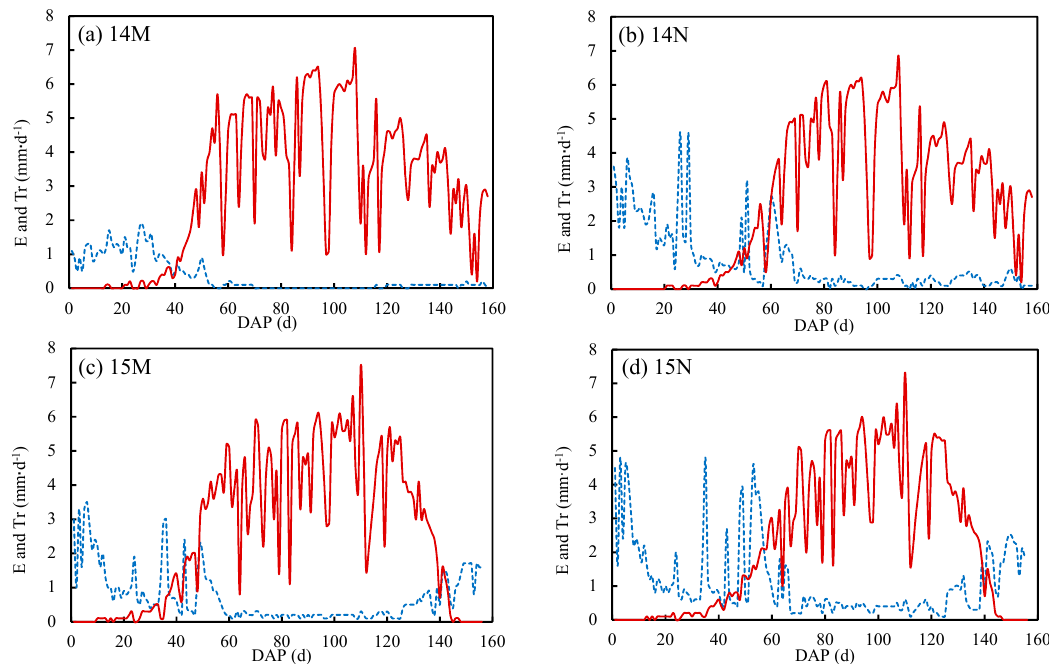
Figure 5. Variations in daily evaporation ( E , - - - - - - -) and transpiration ( Tr , —) against DAP of seed maize for treatments with and without plastic film mulch (M and N) in 2014 and 2015.